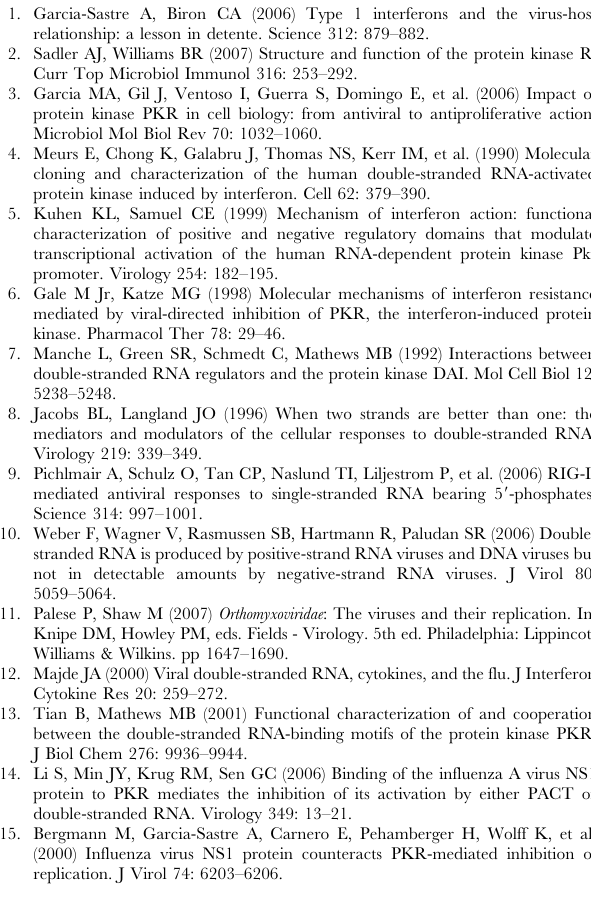
(middle panel). RNA was extracted from the fractions and subjected to reverse transcription (RT)-PCR with primers specific for the vRNA of the NS segment (lower panel). Figure S3 Treatment of infected cells with LMB inhibits the nuclear export of NP. A549 cells were infected with influenza B/ Lee WT virus at an MOI of 1. Cells were mock treated or complemented with LMB starting at 3 hrs p.i.. Cells were lyzed at 15 hrs p.i. and cytoplasmic (C.) and nuclear fractions (N.) were generated. The fractions were analyzed by immunoblotting for viral NP and the marker antigens for the nuclear and cytoplasmic fractions, PARP and tubulin, respectively. Found at: doi:10.1371/journal.ppat.1000473.s003 (0.11 MB TIF) Text S1 This file contains supporting materials and methods. Found at: doi:10.1371/journal.ppat.1000473.s004 (0.03